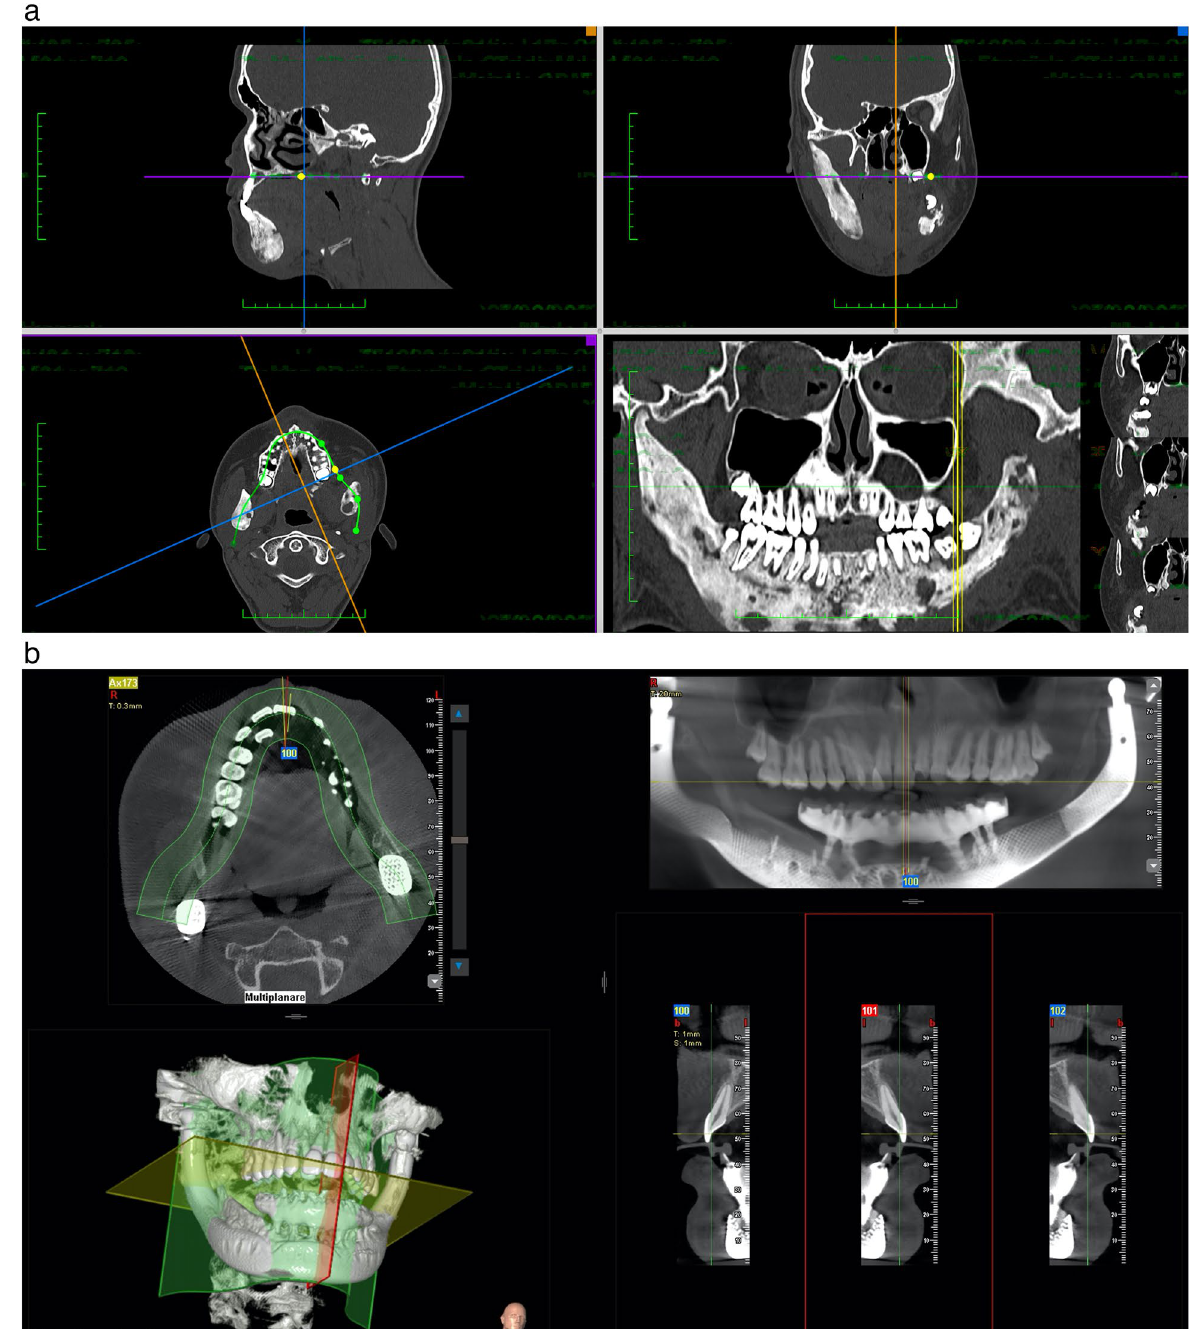
Fig. 6 a Pre-operative CT scans. b Post-operative CT scans at the 18 th -month follow-up after dental implant